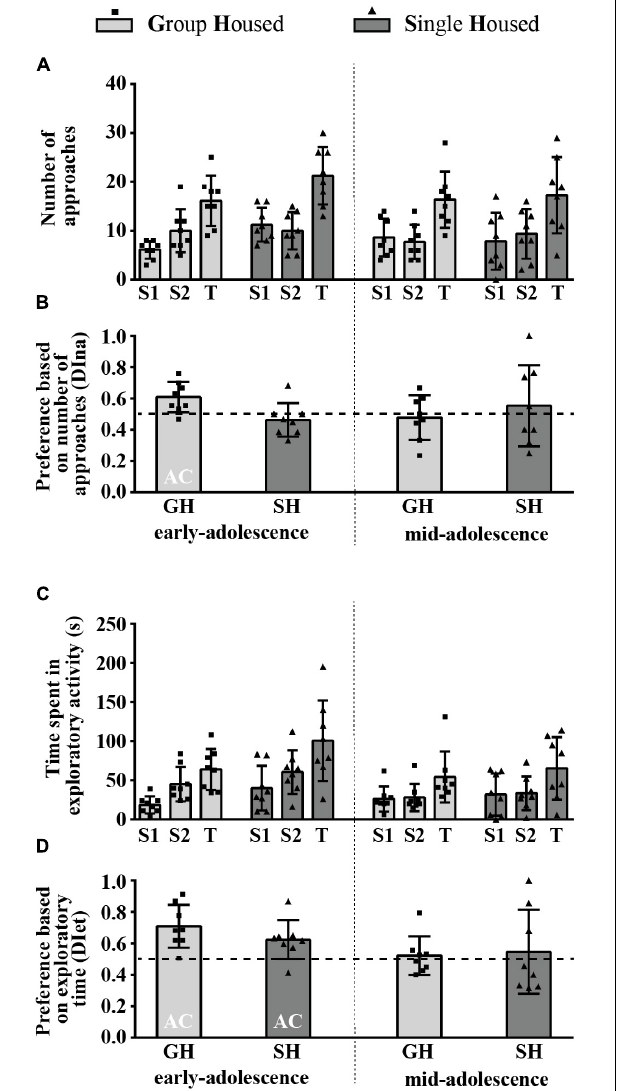
FIGURE 7 | The behavior of peripubertal male rats in a social olfactory test (the preference for social odor phase) at the end of the first week (early-adolescence) and the second week (mid-adolescence) of defined housing, which began on the 29th postnatal day. The data are represented as mean ± SD , with individual data plots along the column bars. (A) The number of approaches to the box with the novel social odor (S1) and to the box with no smell (NS) and the total number of approaches (T). (B) The relative preference for the S1 is based on the number of approaches to the boxes. (C) The time spent in the exploration of the S1 box and the NS box and the total exploratory time (T). (D) The relative preference for the S1 is based on exploratory time. AC – significantly above the chance level (0.5); & p ≤ 0.05 (early-adolescence vs. mid-adolescence (maturation) within the same housing conditions); ∗ p ≤ 0.05 (single housed vs. group housed within the same maturational period). Statistical comparisons and exact p -values are given as Supplementary Table S1 .